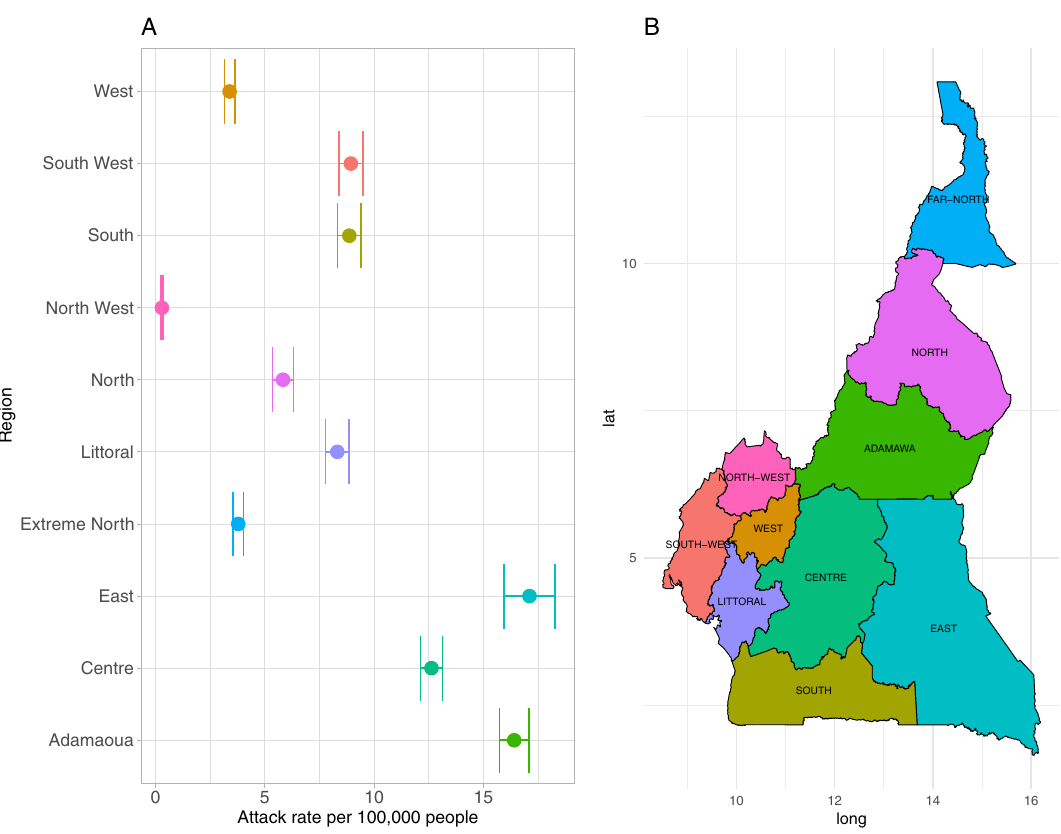
Figure 1. Distribution of ILI reports across the timespan of the study. (A) Attack Rate per 100,000 people (mean and 95% confidence interval) for each of the ten regions. (B) Map of Cameroon with regions for reference. The map was created in R version